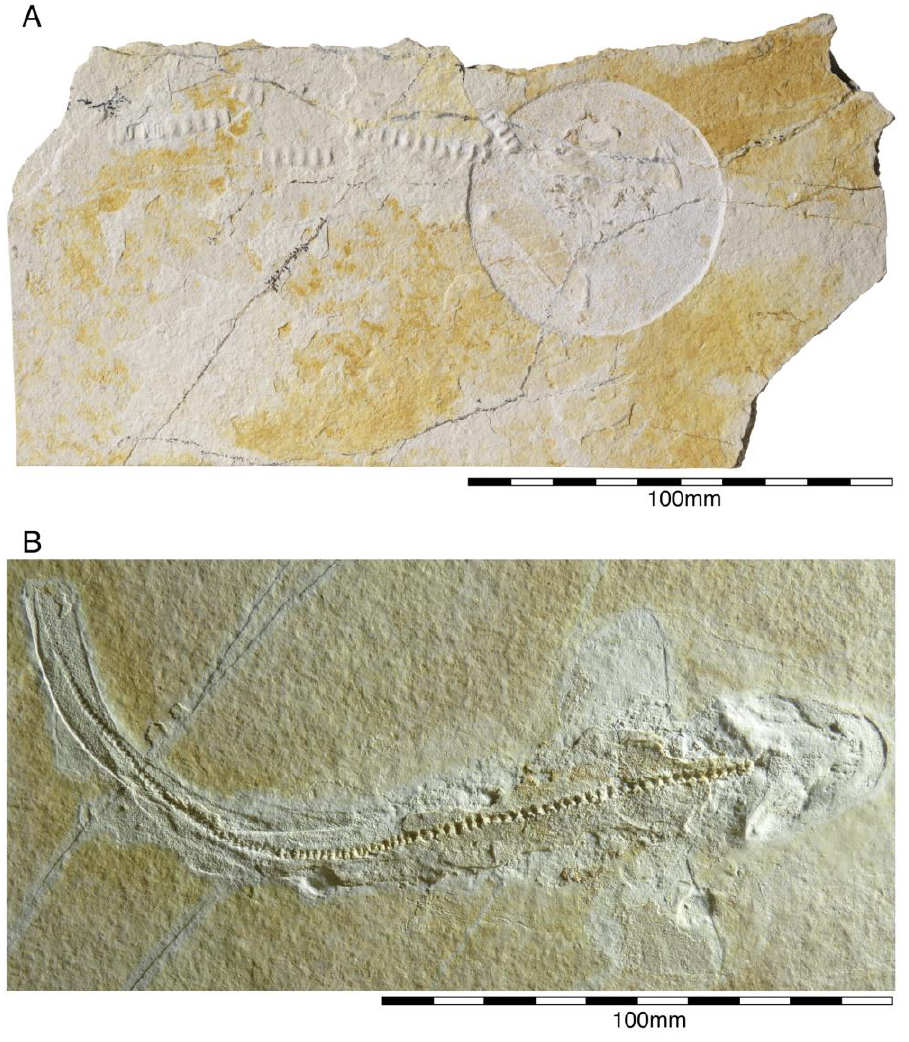
Figure 14. † Synechodus ungeri Klug, 2009 [70]. ( A ) Holotype specimen (SMNS 85975-1) from the Kimmeridgian of Nusplingen. ( B ) Holomorphic specimen (JME SOS 3152 B) from the Tithonian of Solnhofen.